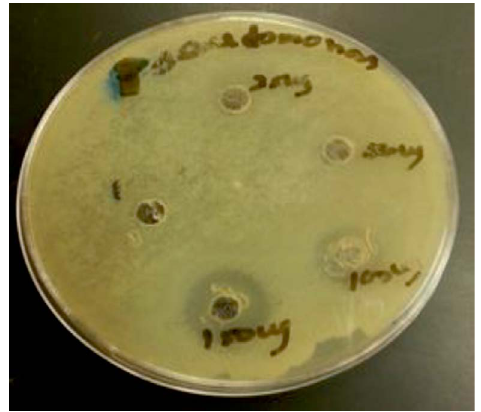
Fig. 5. Zone of Inhibition of chitosan nanoparticles against tested bacteria Pseudomonas